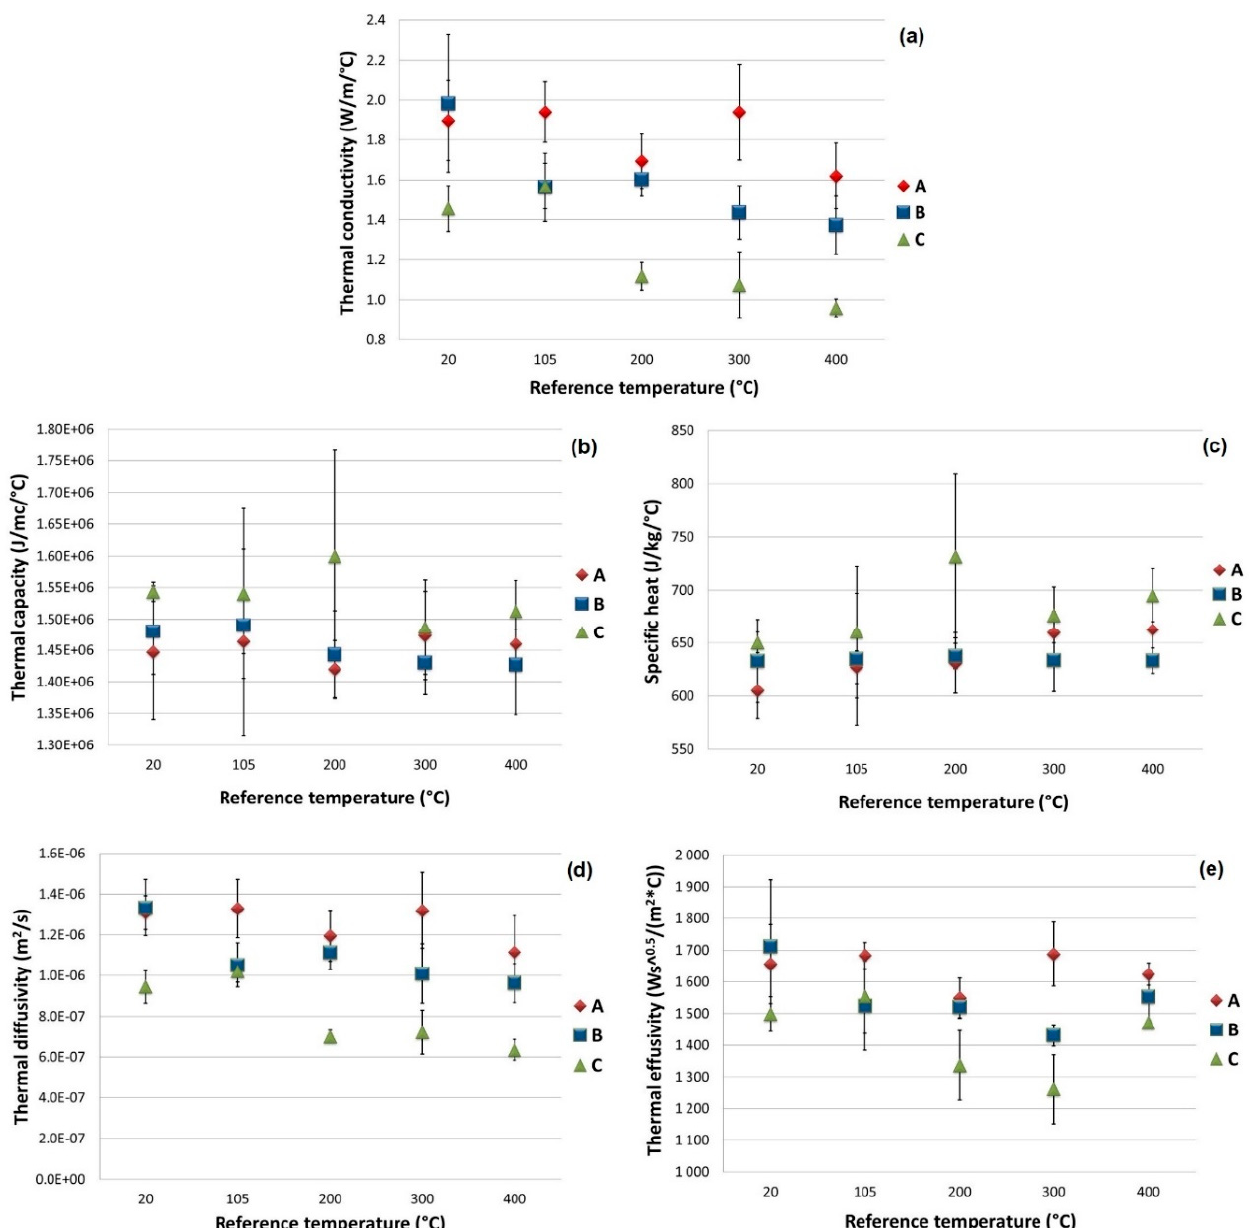
Figure 12. Average thermal properties for the various concrete mix designs, as a function of the heat treatment temperature: conductivity, in W/(m · C) ( a ), capacity, in J/(m 3 · C) ( b ), specific heat, in J/(kg · ◦ C) ( c ), diffusivity, in m 2 /s ( d ) and effusivity, in ( e ), in (W/ ◦ C · m 2 · √ s) .